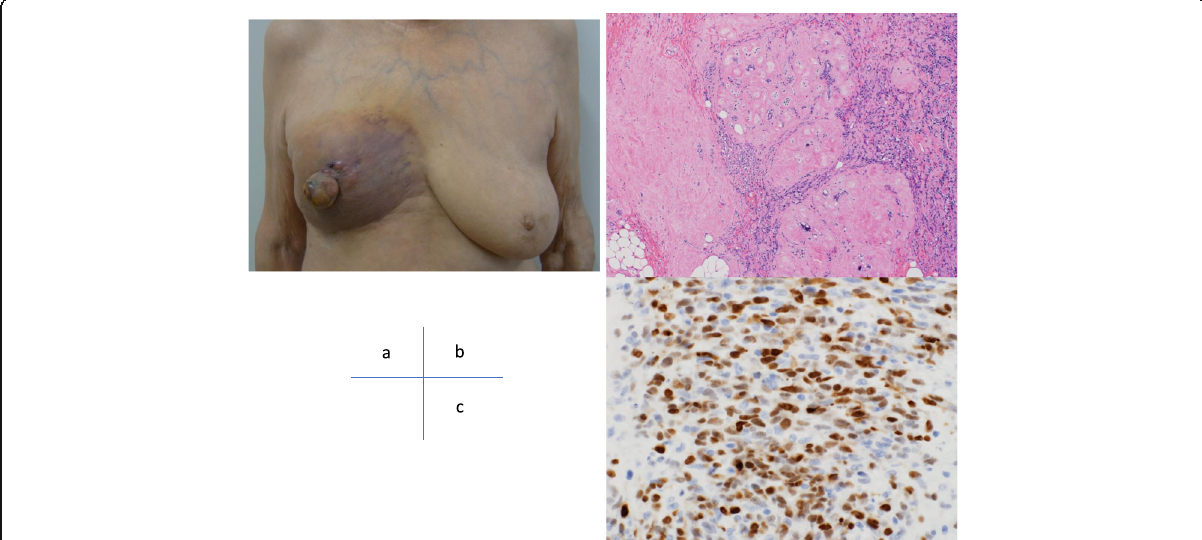
Fig. 1 a Nipple swelling and reddening in of the right breast 5years after right breast conserving therapy and adjuvant radiotherapy. Microscopic appearance of the angiosarcoma. b Neoplastic cells were spread around the irradiated atrophic breast tissue (× 40 magnification) and c Most of the spindle-shaped tumor cells expressed c-myc (× 400 magnification)